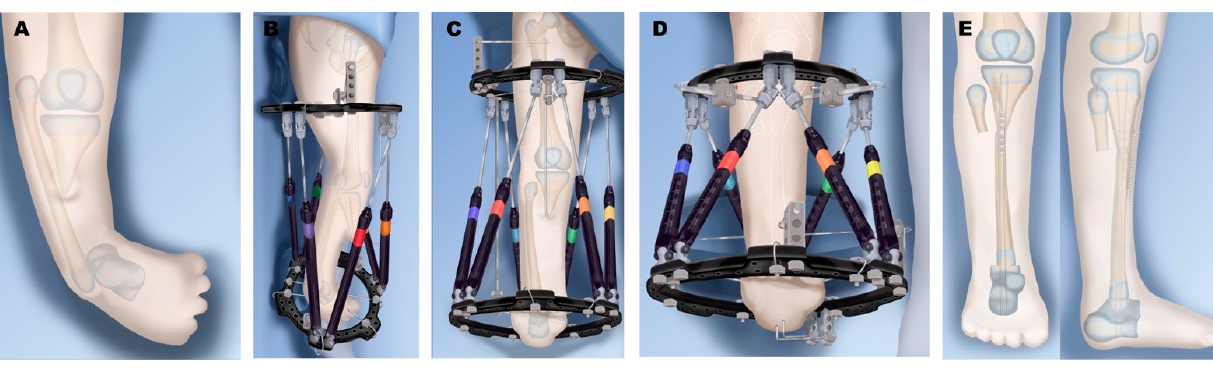
Figure 8. Treatment of Paley type 4A. ( A ) Well-formed proximal tibia and knee with distal tibia aplasia. ( B ) External fixator used to gradually correct equinovarus foot position and distally transport fibular head. ( C ) Fibula brought down to station and foot plantigrade. ( D ) Fibular osteotomy performed with transfer to proximal tibia. Distal fibula epiphysis is fused to talus without disrupting the physis. Fusion stabilized with intramedullary retrograde wires. ( E ) Final results after fixator removal.